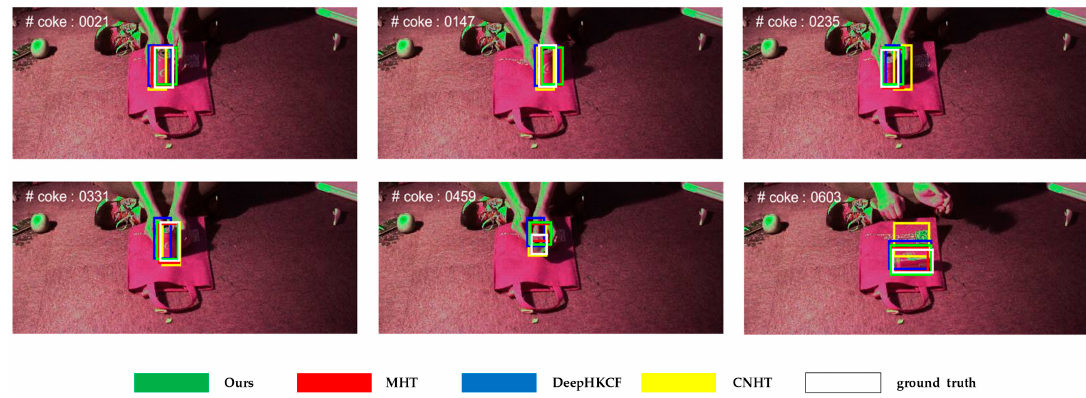
Figure 10. Tracking result of the coke sequence.